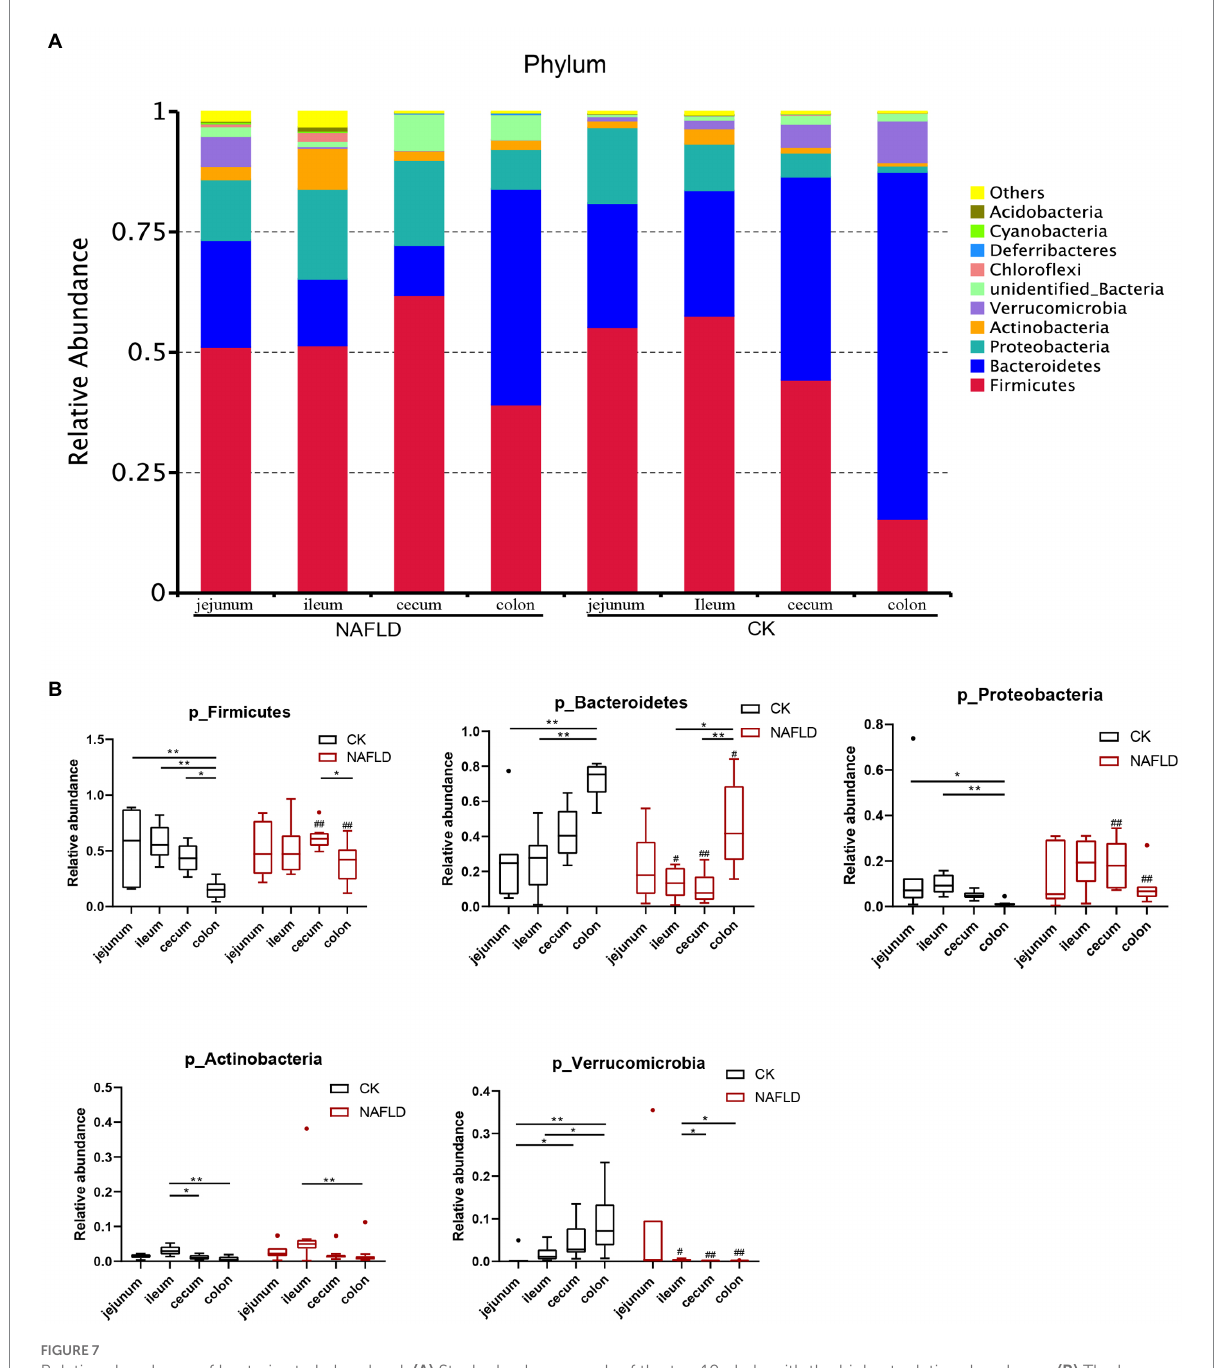
FIGURE 7 Relative abundance of bacteria at phylum level. (A) Stacked column graph of the top 10 phyla with the highest relative abundance. (B) The box diagram was used to analyze the differences in relative abundance of the five phyla with the highest relative abundance. Wilcox Rank-sum test was used to compare the significance of the same intestinal segment between the CK group and the NAFLD group; Kruskal-wallis test was used to compare the differences between different intestinal segments in the same group. *indicate significant difference in the different intestinal segments in the CK group and NAFLD group. # indicates the significant difference in the same intestinal segments between CK group and NAFLD group. *or # p < 0.05; **or ## p <